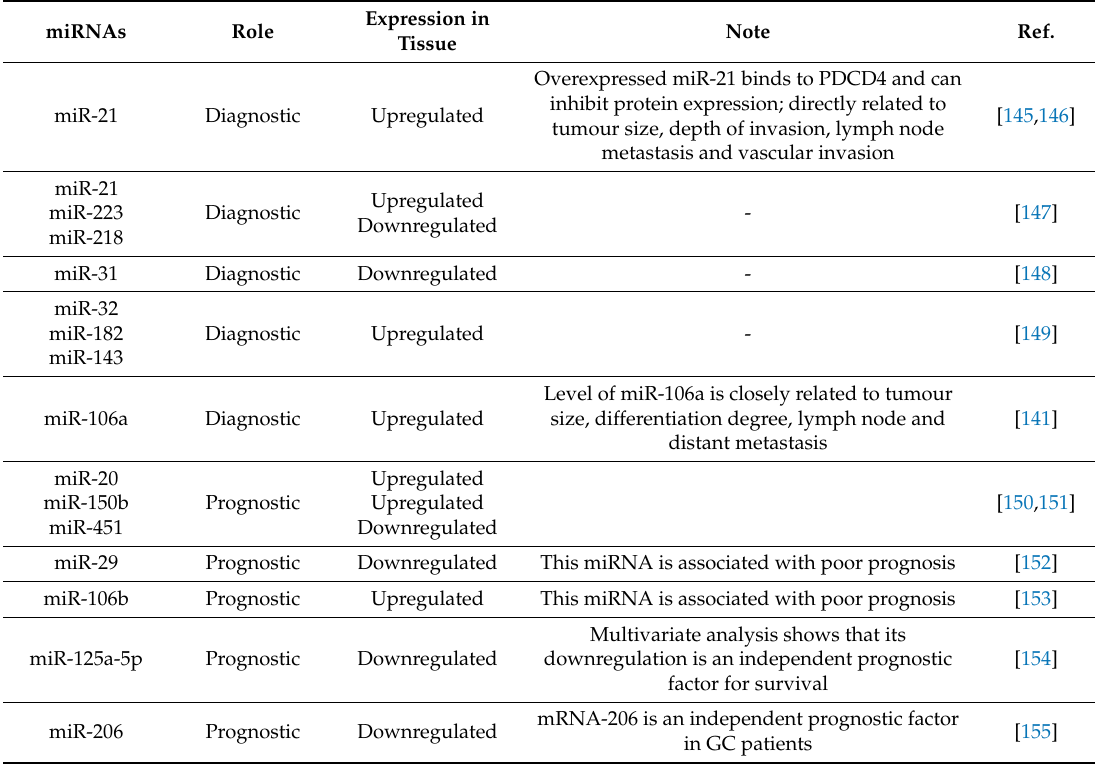
Table 4. Diagnostic and prognostic role of tissue-based GC-related